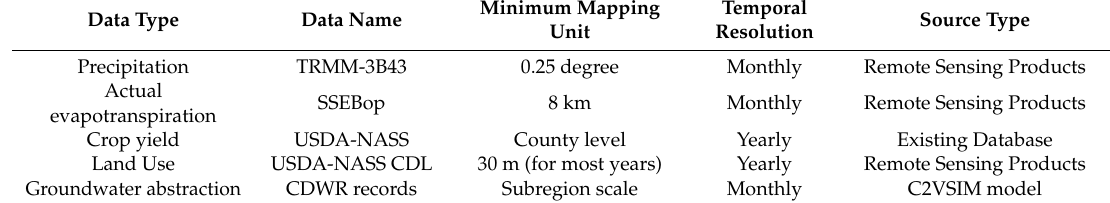
Table 1. Sources of data used in the study.